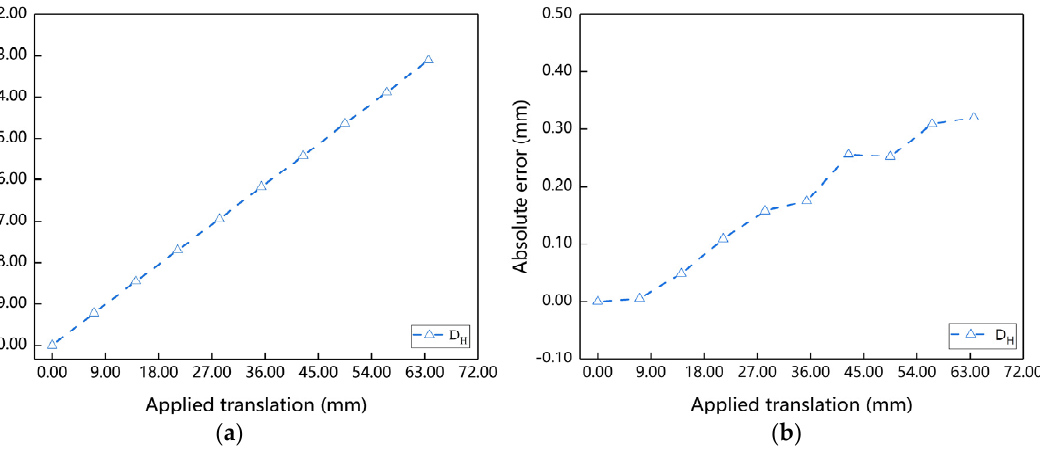
Figure 12. Planar displacement results of target point displacement in the field experiment: ( a ) measured displacement; ( b ) absolute error.